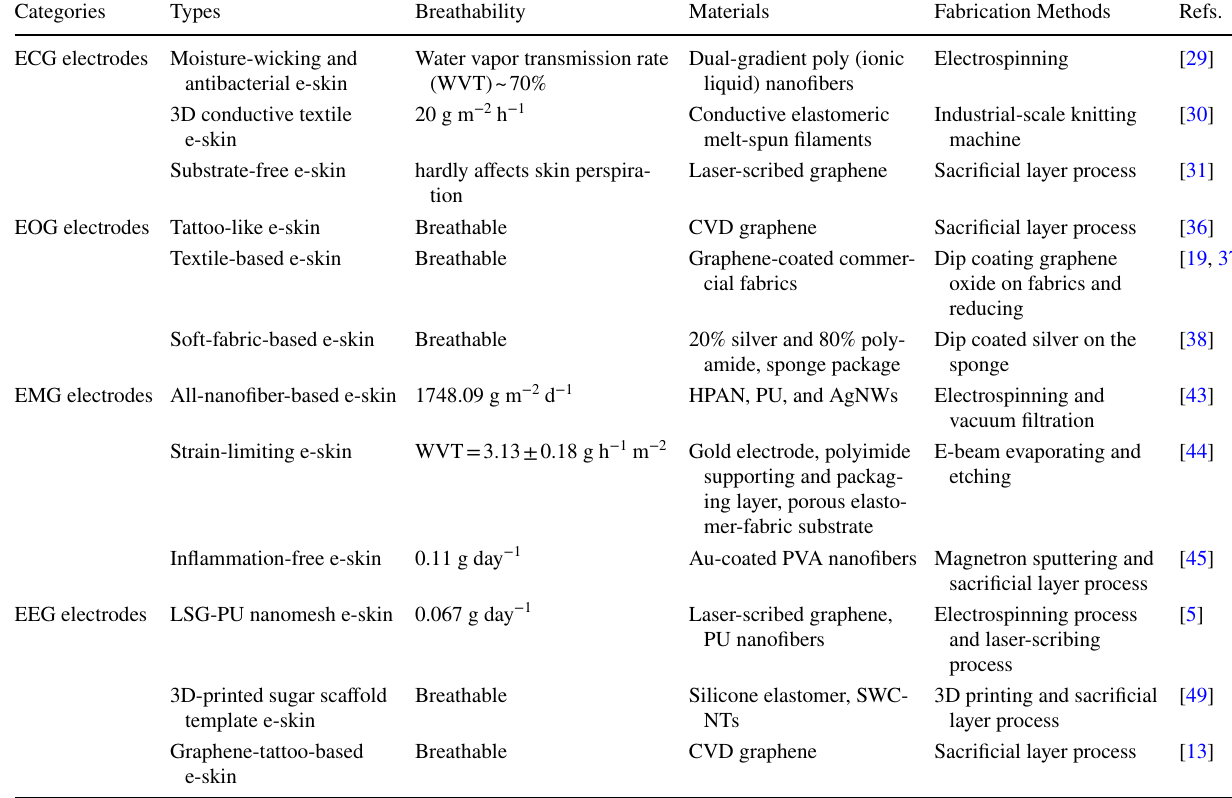
Table 1 Summary of the breathability, materials, and fabrication methods of the typical breathable e‑skin electrodes listed in Sect. 2